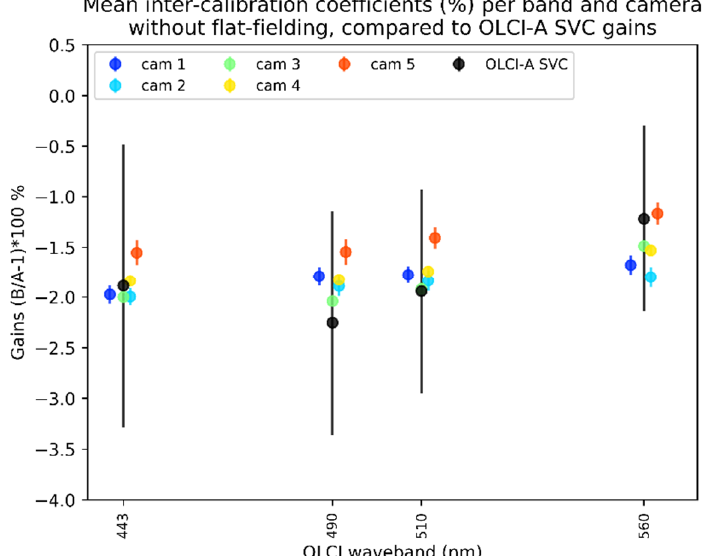
Figure 1. Comparison between Sentinel-3A Ocean and Land Colour Imager (OLCI-A) system vicarious calibration (SVC) gains and the mean inter-calibration coefficients used to align OLCI-A to Sentinel-3B OLCI (OLCI-B) per camera. Adapted from [15].